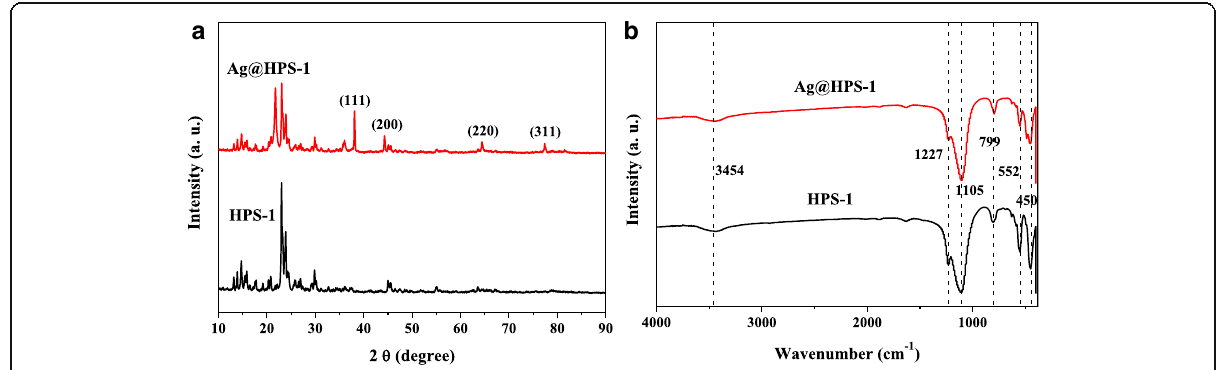
Fig. 3 a XRD patterns. b FTIR spectra of the as-prepared HPS-1 and Ag@HPS-1